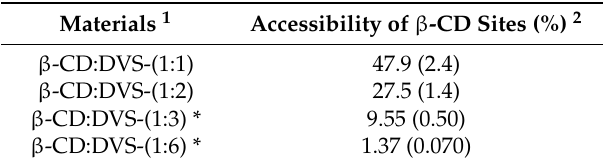
Table 1. Inclusion site accessibility of β -CD homopolymers cross-linked with